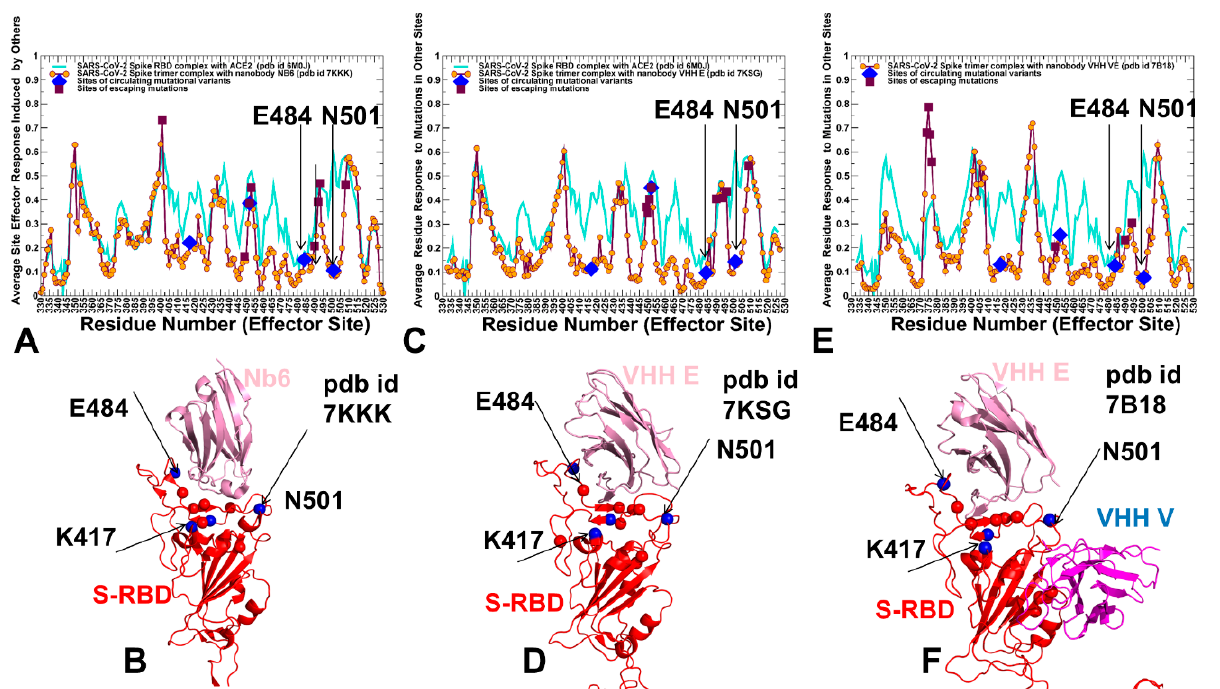
Figure 8. The PRS effector profiles for the SARS-CoV-2 S trimer complexes with Nb6 nanobody, pdb id 7KKK ( A ), VHH E nanobody, pdb id 7KSG ( C ), and VHH VE nanobody, pdb id 7B18 ( E ). The PRS effector profiles for the SARS-CoV-2 S complexes are shown in maroon-colored lines with orange-colored filled circles. For comparison, the PRS profiles are superimposed with the respective profiles for the S-RBD complex with ACE2 shown in cyan-colored lines (pdb id 6M0J). The sites of escaping mutations for nanobody binding are indicated by maroon-colored filled squares, and RBD sites K417, E484, and N501 targeted by global circulating variants are highlighted in blue-colored filled diamonds. The positions of sites of circulating variants E484 and N501 are indicated by arrows on panels ( A , C , E ). These sites are aligned with the local minima of the PRS profile and may act as receivers/transmitters of the allosteric signal involved in functional RBD movements. Structural maps of the allosteric effector hotspots corresponding to the local maxima of the PRS profile are shown for the SARS-CoV-2 S trimer complex with Nb6 nanobody ( B ), S trimer complex with VHH E nanobody ( D ), and S trimer complex with VHH E/VHH V nanobody ( F ). The S-RBDs are shown in red-colored ribbons rendered using UCSF ChimeraX [108]. Structural positions of allosteric effector centers are shown in red spheres. The important functional sites subjected to circulating mutations K417, E484 and N501 are shown in blue spheres. The bound nanobodies Nb6 ( B ) and VHH E ( D ) are shown in pink-colored ribbons. VHH E/VHH V nanobody is shown in pink and magenta-colored ribbons, respectively ( F